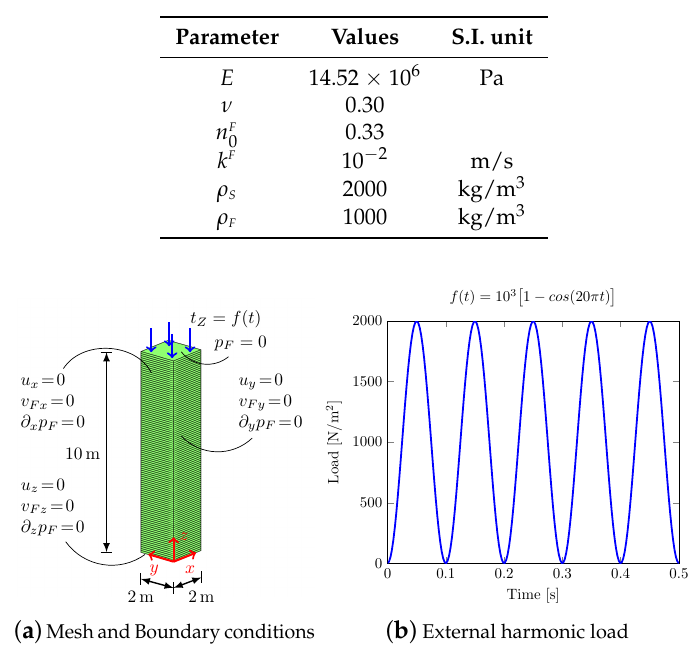
Figure 2. 1D model (benchmark